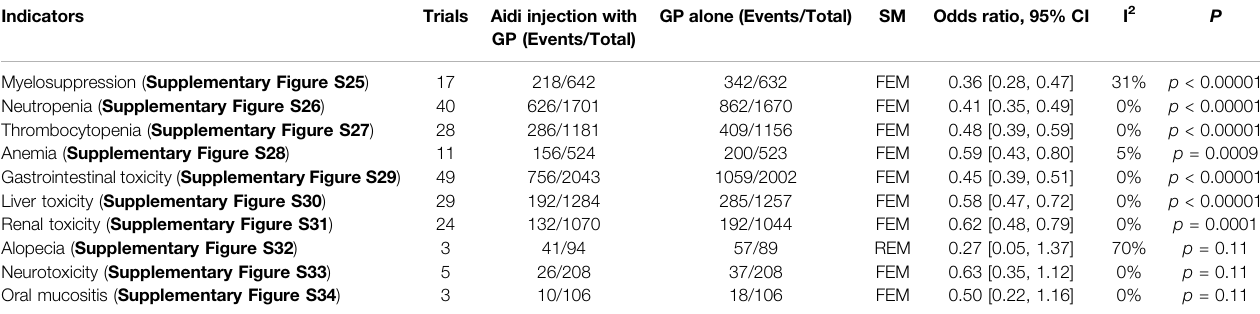
TABLE 2 | Meta-analysis results of adverse drug reactions ( Supplementary Figures S25 – S34